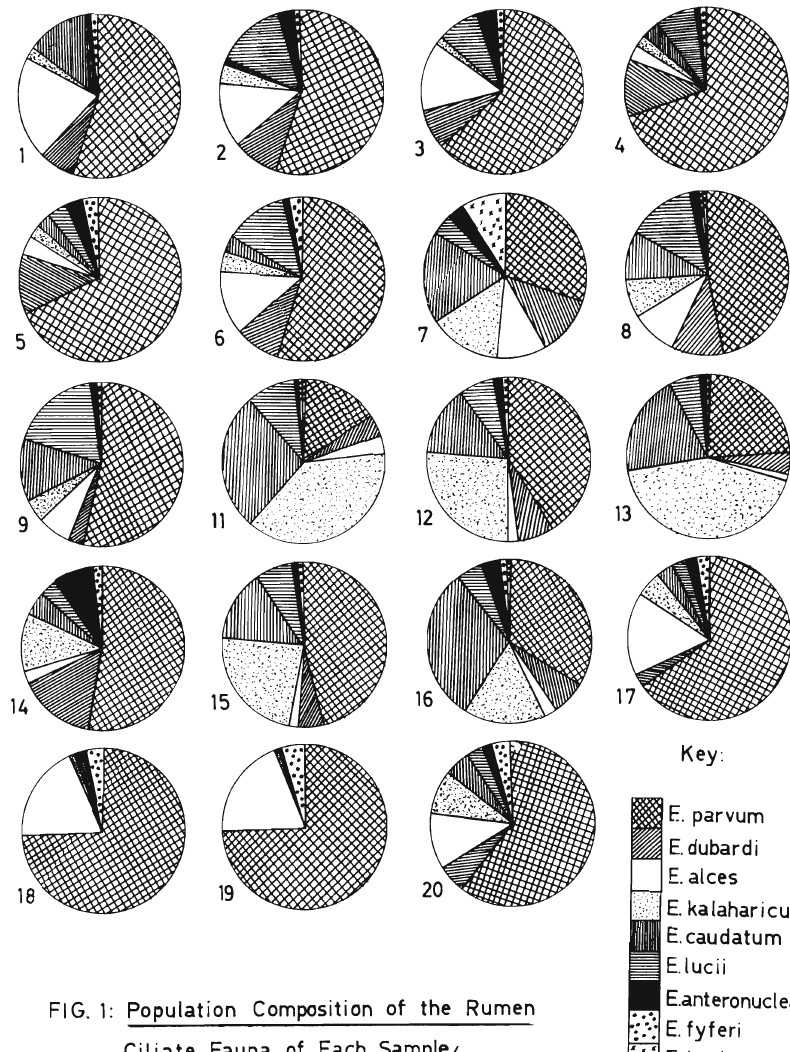
FIG. 1: Population Composition of the Rumen Ciliate Fauna of Each Sample/